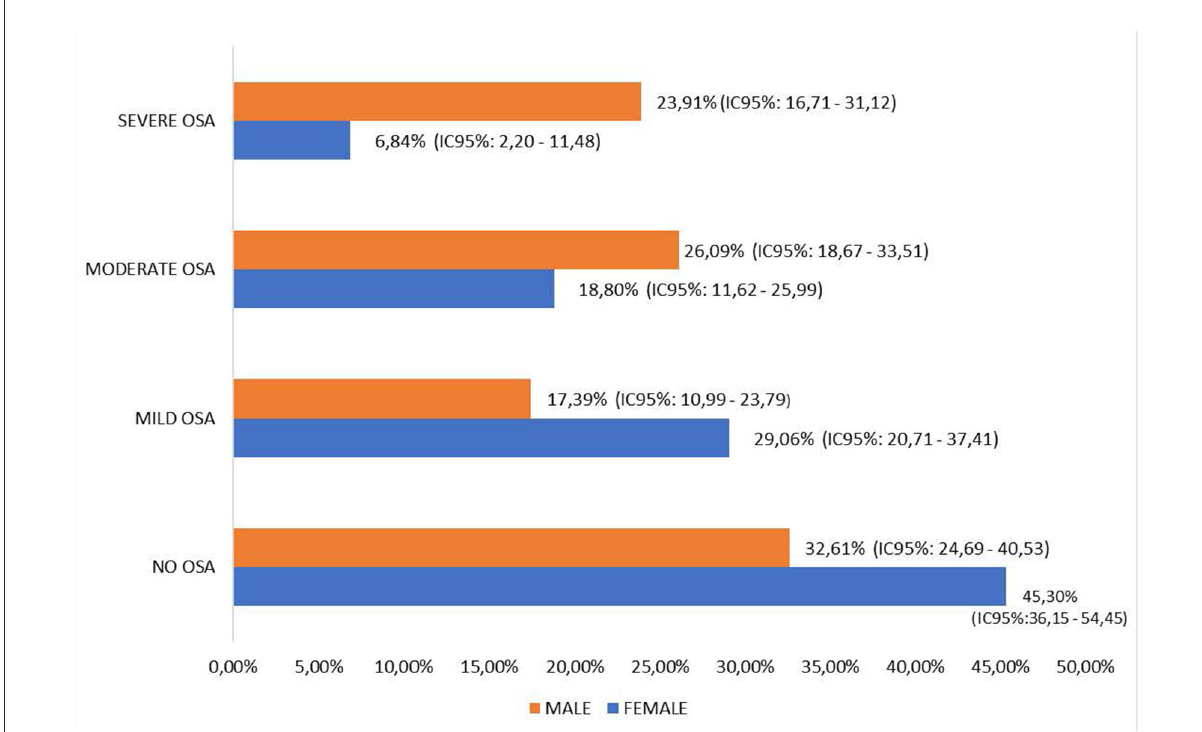
FIGURE2 Distribution of OSA by gender. Population parameters with a 95% confidence level. NO OSA: Pearson’s Chi square = 4.310, p = 0.038. MILD OSA: Pearson’s Chi square = 4.906, p = 0.027. MODERATE OSA: Pearson’s Chi square = 1.191, p = 0.167. SEVERE OSA: Pearson’s Chi square = 13.682, p <